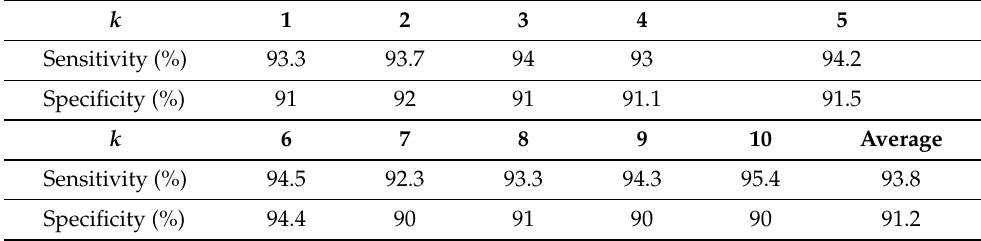
Table 7. The k -fold cross-validation results of the proposed method.